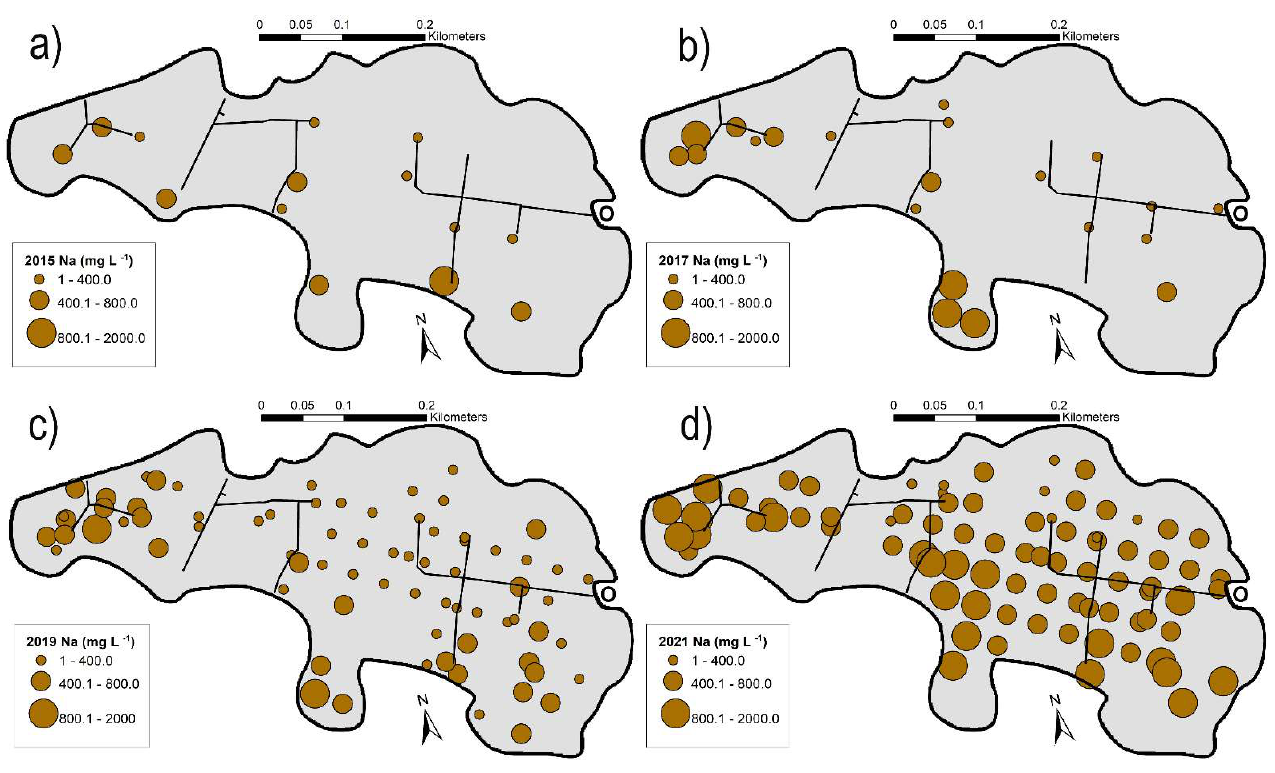
Figure 5 . Distribution of Na + concentrations in surficial water across Sandhill Wetland in ( a ) 2015, ( b ) 2017, ( c ) 2019, and ( d ) 2021. Concentrations shown divided into three categories (1–400, 401–800, and 801–2000 mg L −1 ). O = Outlet of Sandhill Wetland.